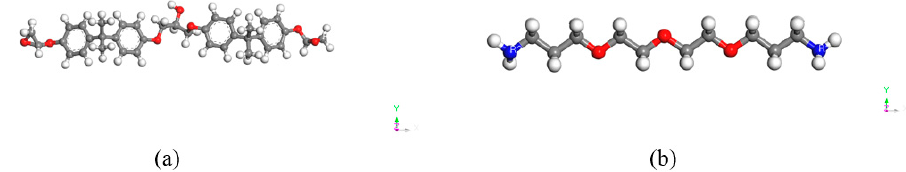
Figure 3. Molecular configurations of ( a ) bisphenol A diglycidyl ether ‐ based epoxy resin and ( b ) a polyether diamine as curing agent.